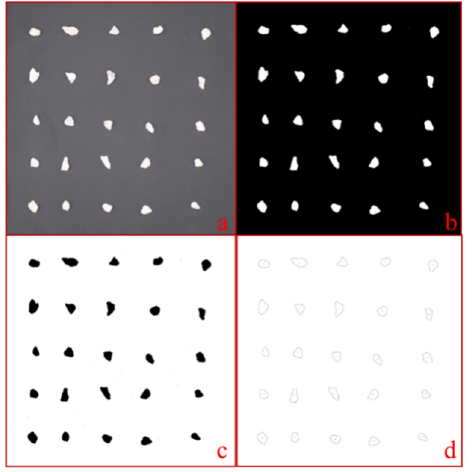
Figure 5. Conversion example of irregular sand image: ( a ) Original RGB image; ( b ) Converted into an 8-bit grayscale image; ( c ) Thresholding of images; ( d ) Draw profile.